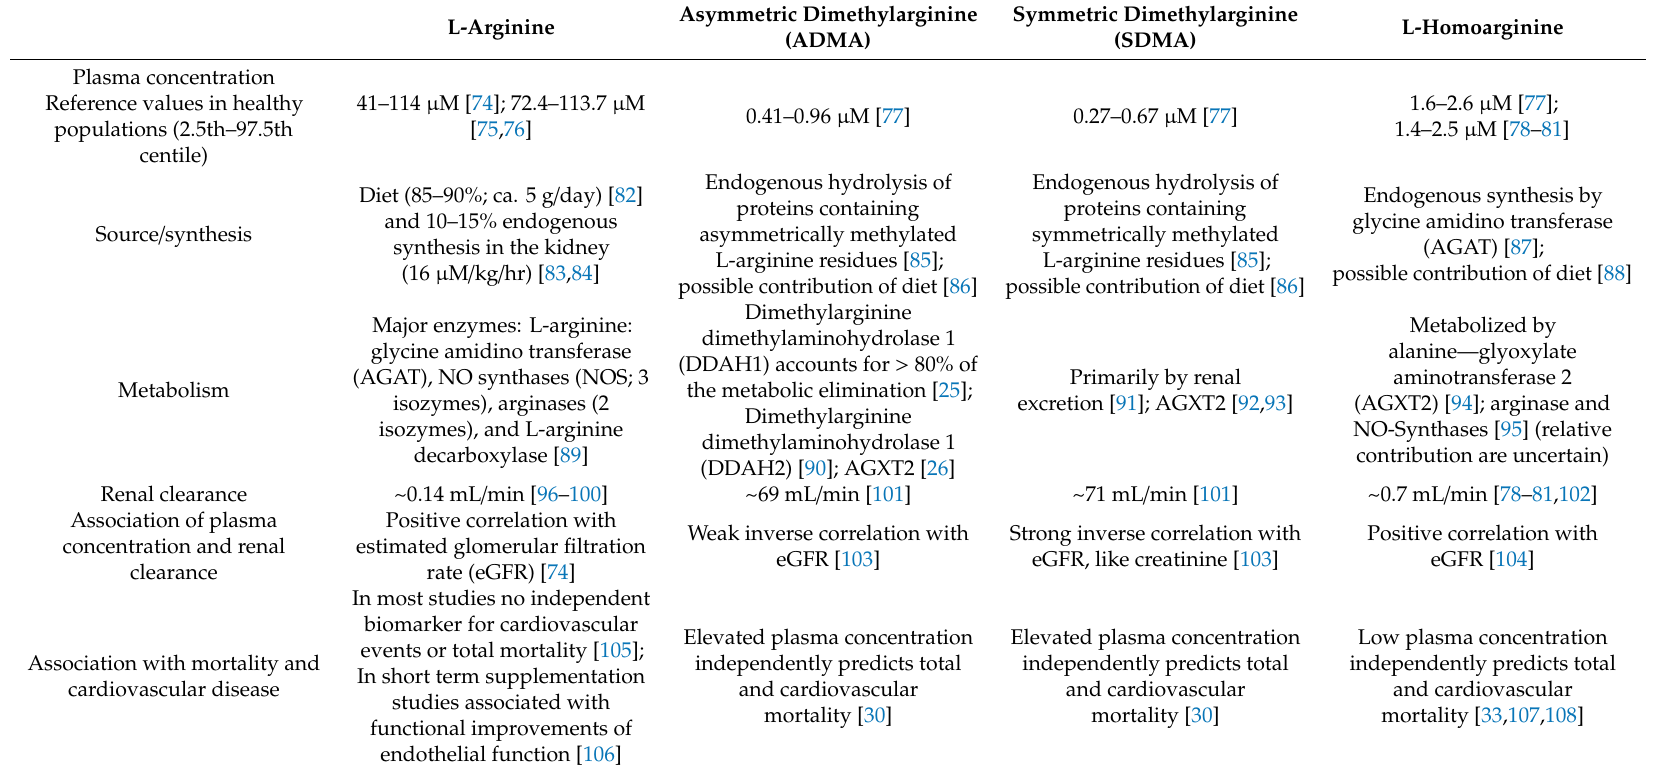
Table 1. Physiological characteristics of L-arginine and its